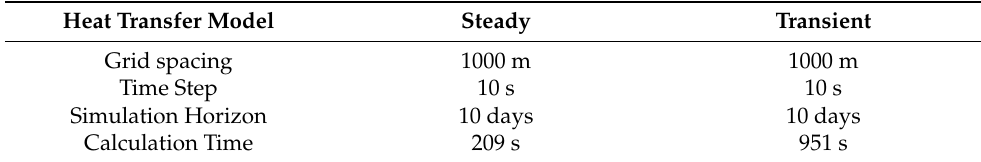
Table 4. Grid calculation parameters.